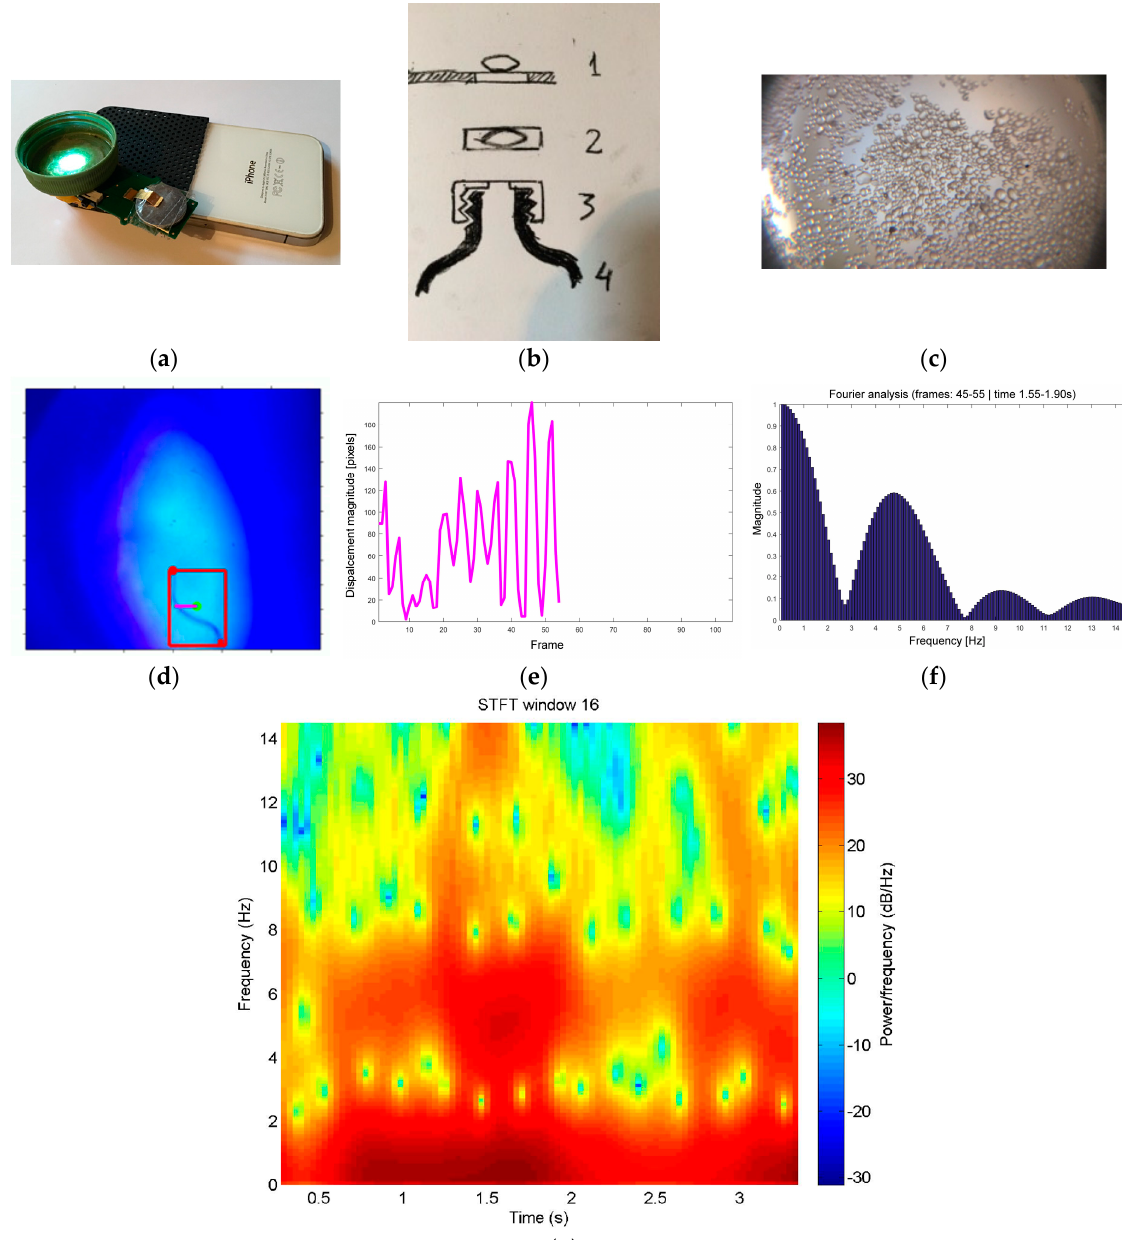
Figure 6. ( a ) The imaging device: Video capture with iPhone 4S at a frame rate of 25 FPS using add-on lens with resolving power of about 10 microns from KeepLoop ® fitted into screw cap of plastic bottle containing 10 mL water sample; ( b ) Schematic figure. 1. iPhone 4S; 2. KeepLoop ® lens; 3. Screw cap with protective coverslip at focal distance; 4. Plastic bottle containing sample; ( c ) (Video S8) Video recording of marker beads 5–200 microns in diameter suspended in water. Imaging with iPhone 4S and screw cap-mounted lens; ( d – f ) (Video S9) Turbatrix aceti at the water/air interphase. Illumination using external UV/blue light emitting diode (LED). Computer vision: The worm was extracted using Maximally Stable Extremal region, its ends were located, and the worm displacement from the line connecting the ends was monitored over time. The obtained oscillating signal was analyzed using Fourier transformation. The work flow is similar to what has been used for analysis of human motion [45]; ( g ) Spectrogram of Turbatrix aceti motility based on motility signal analysis. The most significant activity occurs at 1.5 seconds, having the fundamental frequency at 5 Hz. While typically used for sound analysis such as singing voice recognition, it is suggested that the spectrogram could be used as a feature source for motion classification